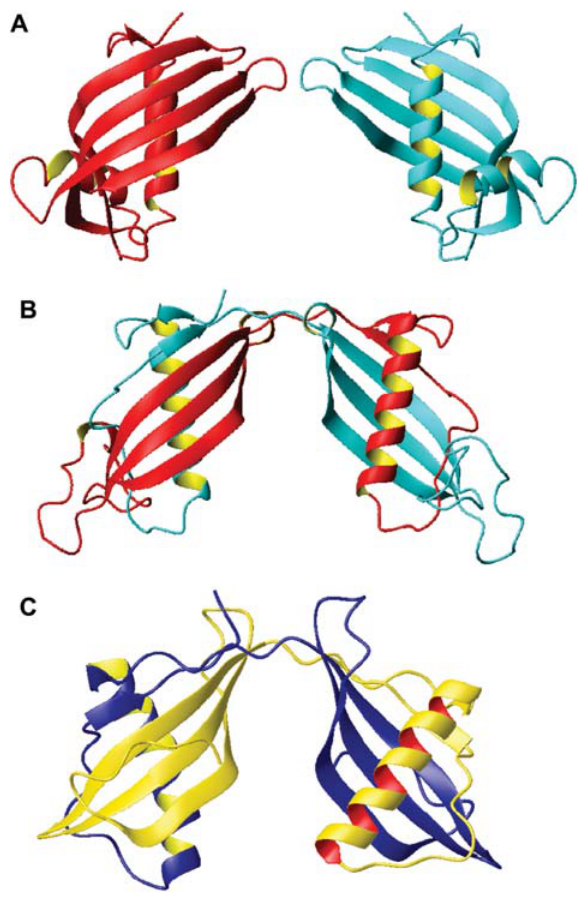
Figure 4 Swapped dimers of cystatins. (A) Two monomers of cystatin C. (B) Swapped dimer of N-trun- cated human cystatin C. (C) Swapped dimer of the P79S mutant of Y31-stefin B. The models were generated with MOLMOL